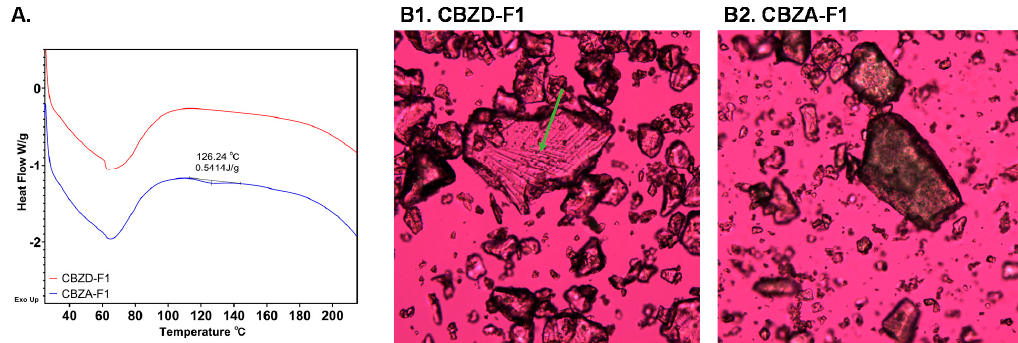
Figure 6. A . DSC thermograms of CBZD-F1 (red, 10% CBZ dihydrate) and CBZA-F1 (blue, 10% form-III CBZ anhydrate). B . PLM images (100×) of B1. CBZD-F1 and B2. CBZA-F1.